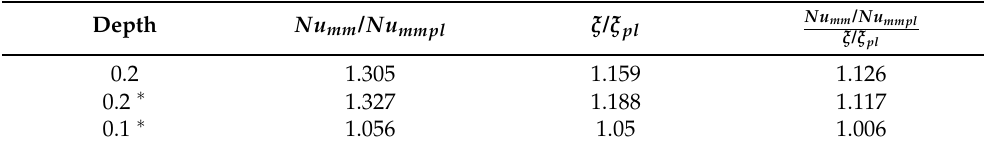
Table 4. Comparison of the heat transfer, hydraulic losses, and thermal-hydraulic efficiency of a channel section with two spherical dimples.